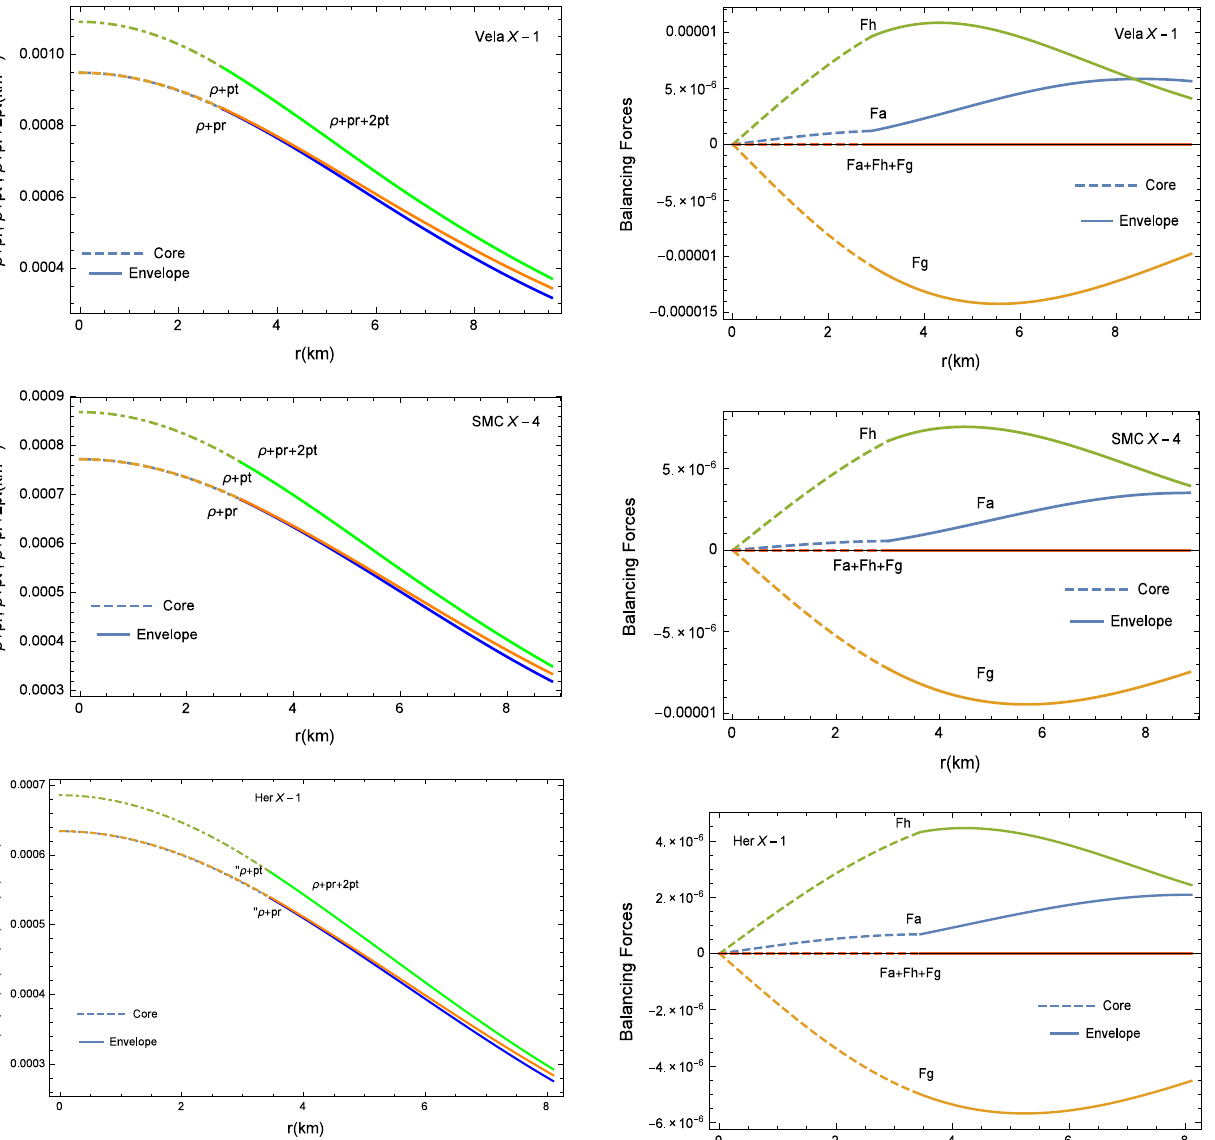
Fig. 11 Variation of energy conditions with radial coordinate r for (i) the neutron star in Vela X-1(upper) (ii) SMC X-4 (middle) (iii) Her X-1 (lower)